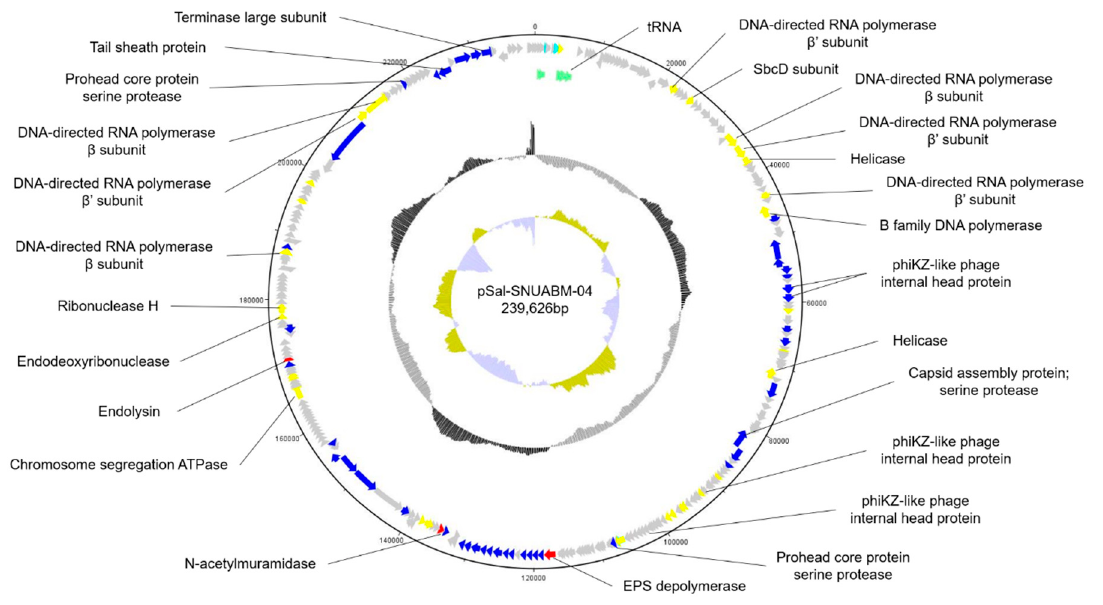
Figure 3. Genome map of pSal-SNUABM-04. The open reading frames (ORFs) are indicated by specific colors according to their functional categories. The GC skew is shown as inner circles holograms in cyan and green. GC content is indicated by black circular hologram. Red; lysis-related gene. Blue; structure and packaging related genes. Yellow; nucleotide metabolism-related genes. Gray; hypothetical gene. Green; tRNA.